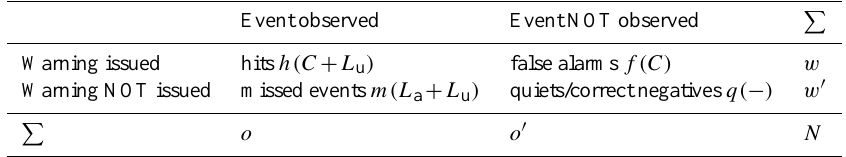
Table 1. Contingency table. The consequences of the items listed are in brackets. Event observed Event NOT observed P Warning issued hits h(C + L u ) false alarms f (C) w Warning NOT issued missed events m(L a + L u ) quiets/correct negatives q( − ) w 0 P o o 0